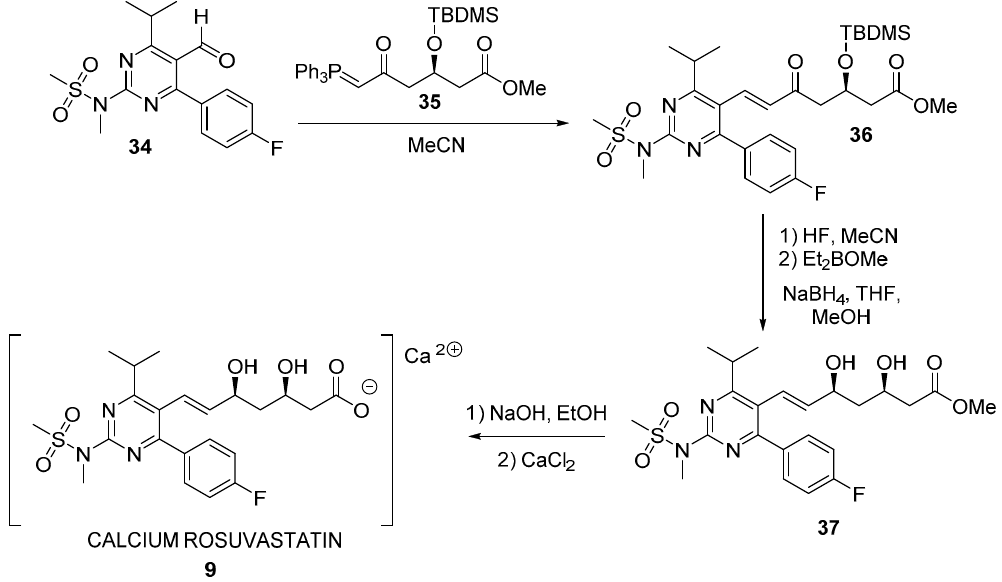
Figure 8. Final steps in the chemical synthesis of rosuvastatin 9 .